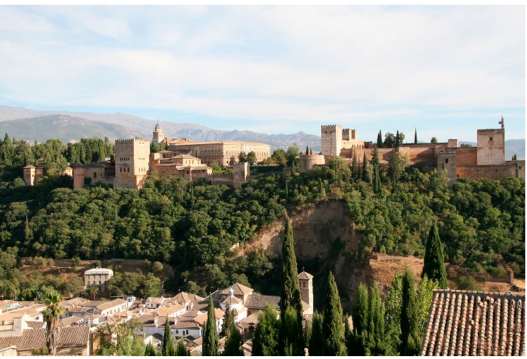
Figure 1. The Ahambra on Sabika hill, the visible manifestation of power, rising strategically and symbolically above the city. © Mar í a Elena D í ez Jorge, 2014.